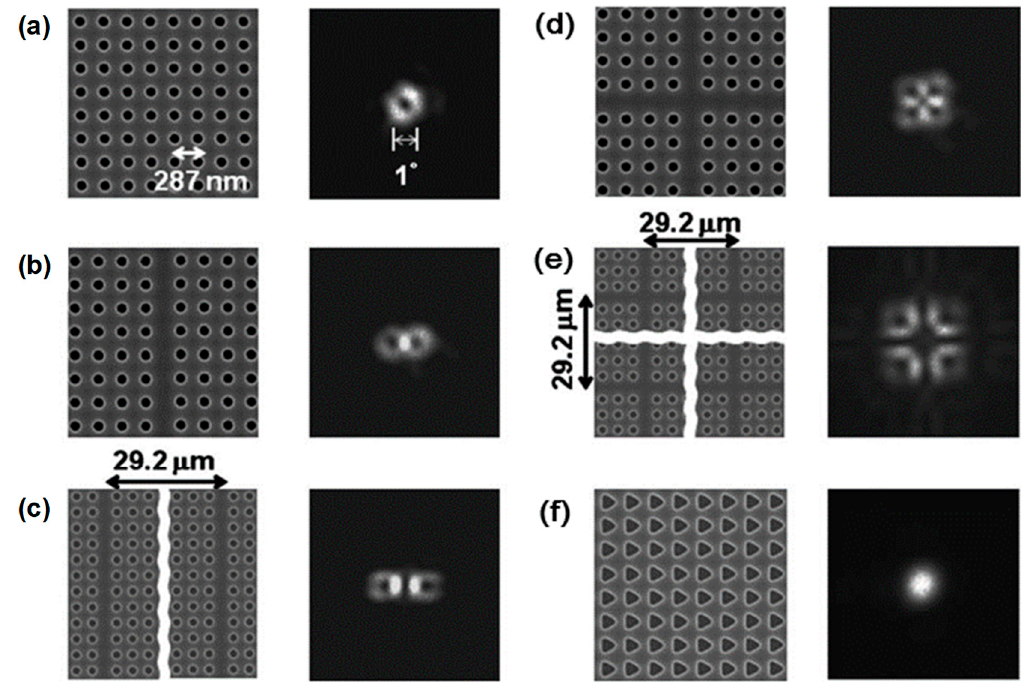
Figure 5. SEM images of devices (left panels) for controlling far-field patterns (FFPs), and experimental FFPs (right panels). Results for ( a ) circular lattice points without phase shift, ( b )–( e ) circular lattice points with phase shifts at different areas, and ( f ) triangular lattice points without phase shift. Reprinted by permission from Springer Nature, Nature [7], 2006.